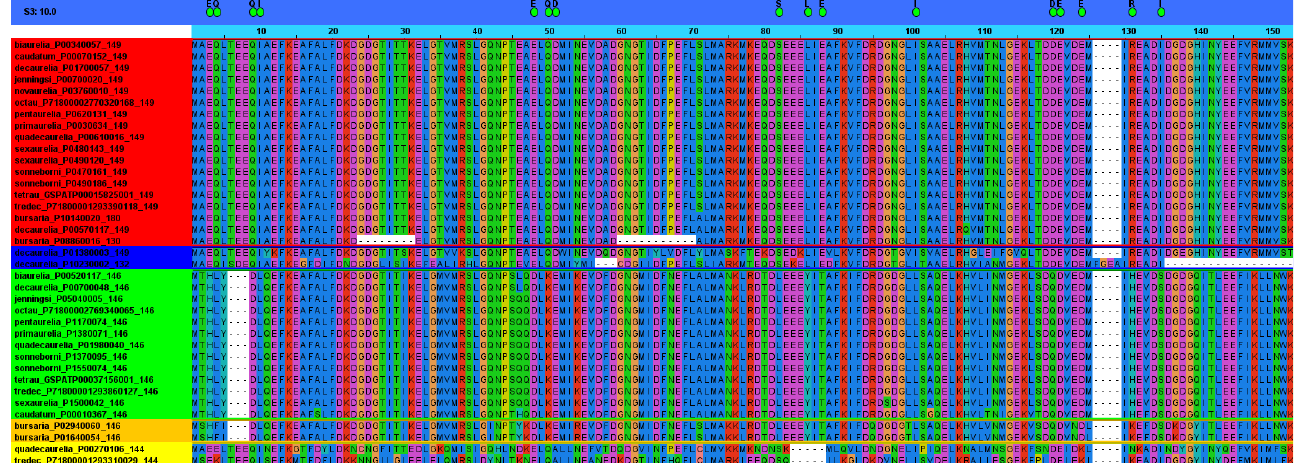
Figure 3. Specificity determining the positions in a multiple alignment of Paramecium CaMs. The Paramecium subgroup of the protein sequences from orthogroup OG0001068 were aligned using MAFFT [126] and the resulting file uploaded in JDET [129]. Specificity-determining positions were calculated using the S3DET algorithm [129]. The figure shows a partial alignment of the output window. According to this analysis, uploaded CaM sequences were divided in five specificity subgroups, which are highlighted in red, blue, green, orange, and yellow boxes in the leftmost column of the window. This column corresponded to the identification of the proteins, but due to space restrictions, only the species name, accession number, and size of the corresponding proteins were written. The green circles mark the alignment positions that are SDPs allowing discrimination among groups.